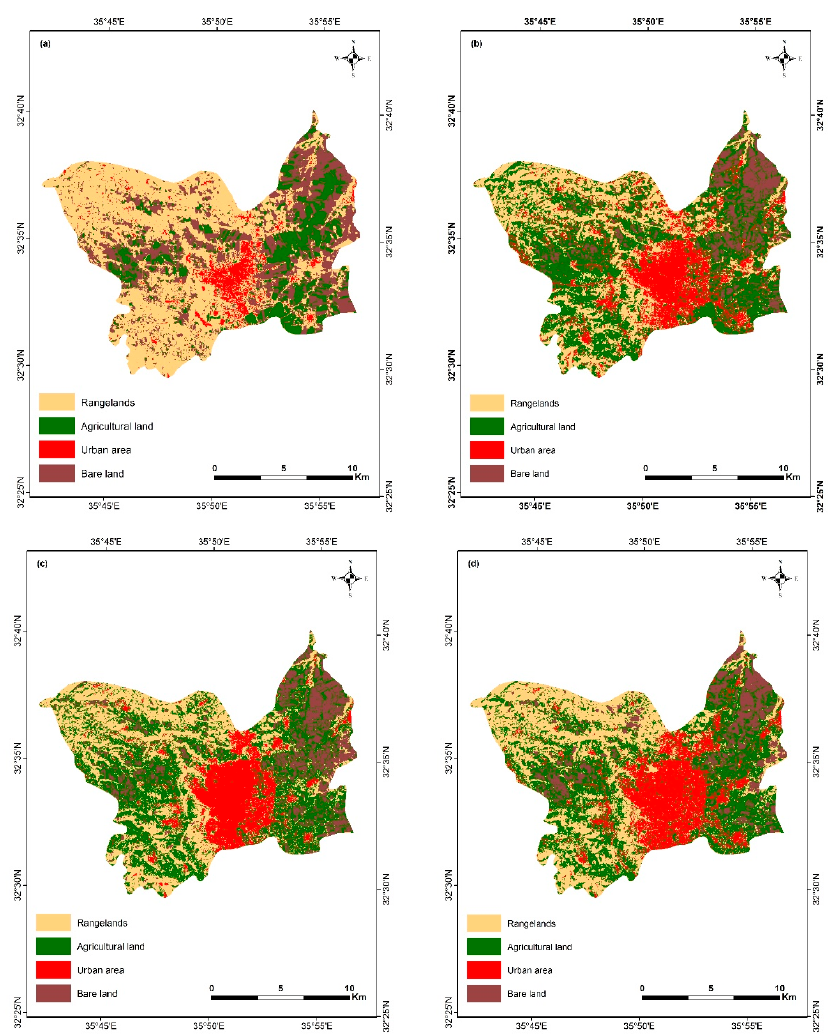
Figure 3. Graphs illustrating the proportion of each land cover class over the study period.